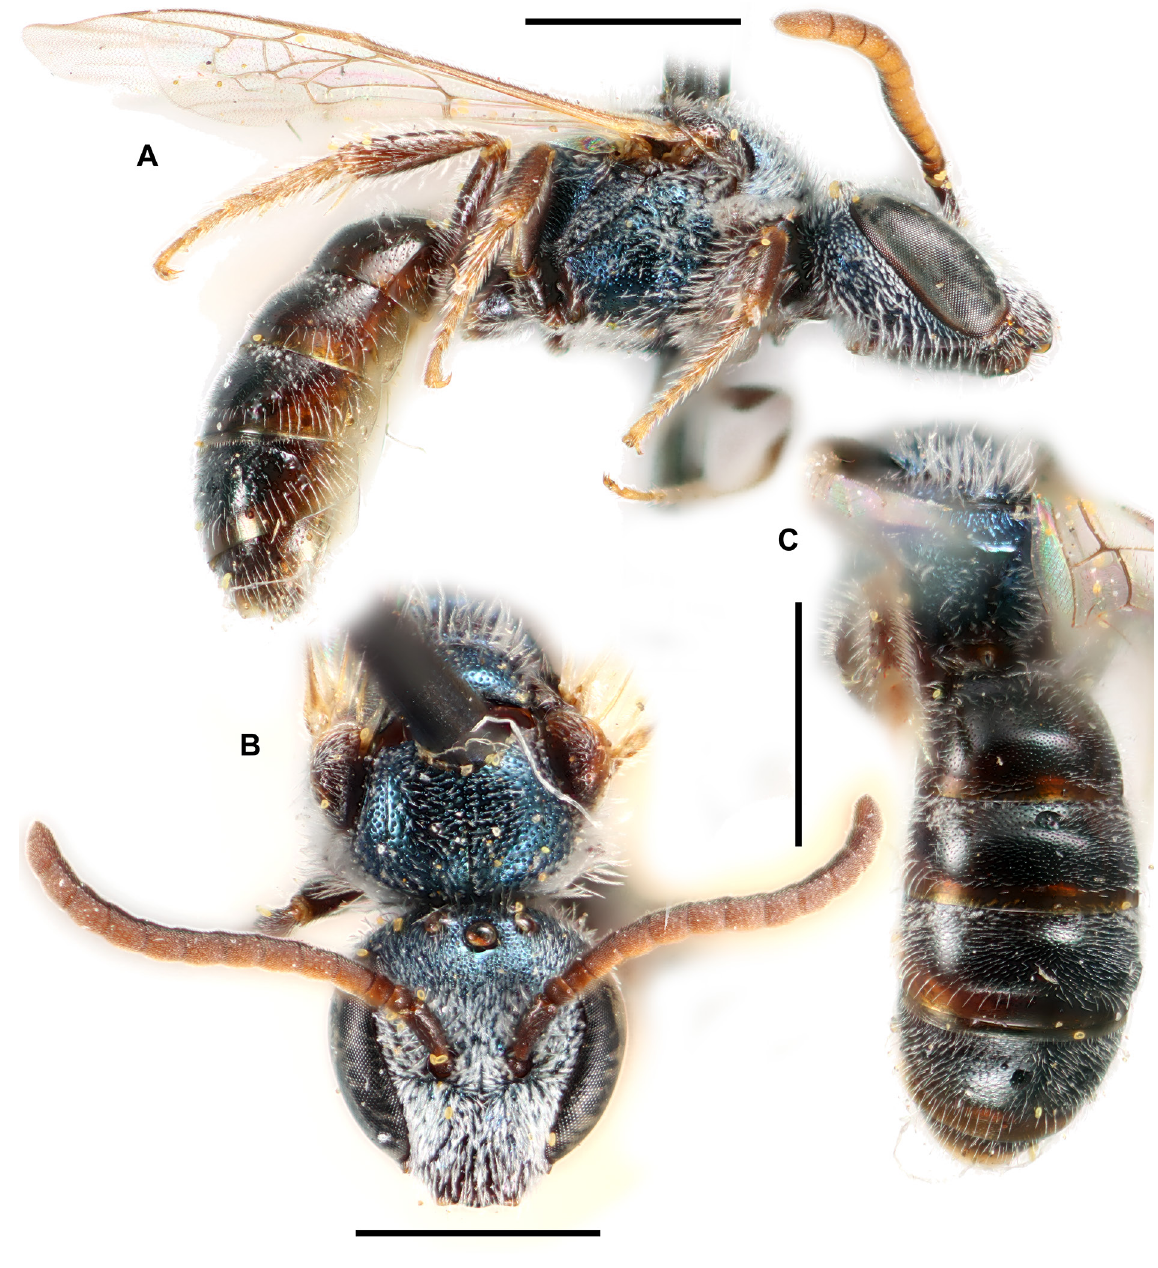
Fig. 25. Lasioglossum ( D .) gaudiale (Sandhouse, 1924), ♂, holotype (USNM 26418). A . Lateral habitus. B . Face and mesonotum. C . Metasoma and propodeum. Scale bars = 1